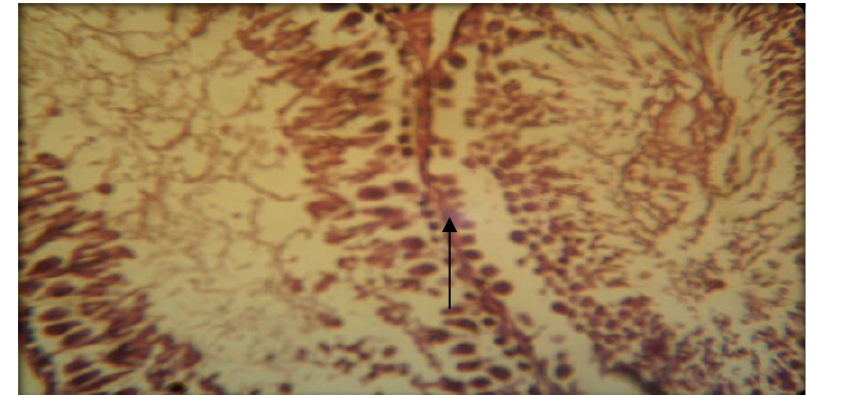
Figure (3): Histological section of rat testis treated with methionine overload and alcoholic extract of black current (GII).Show regression of pathological lesion ( ) (H&E